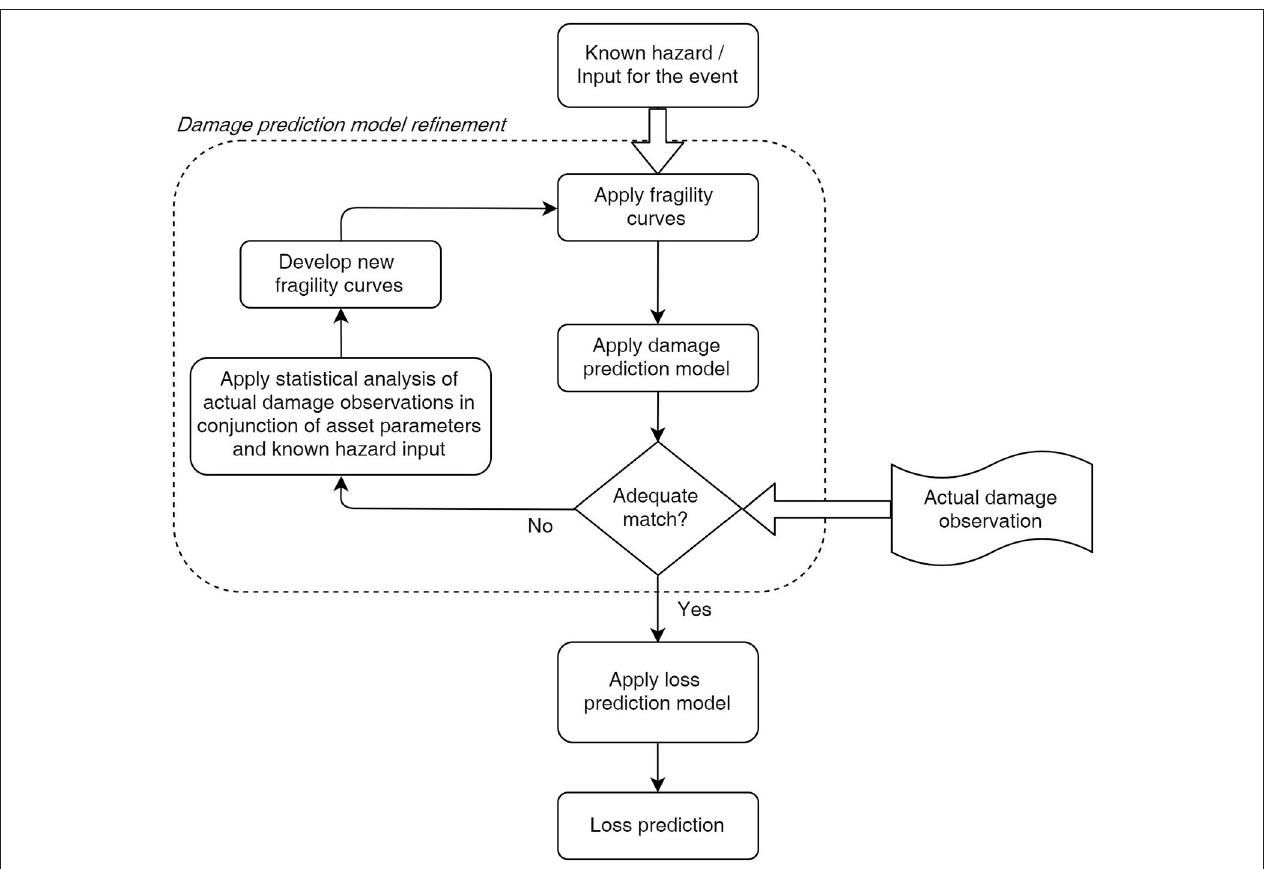
FIGURE 3 | Damage assessment in the earthquake risk reduction.